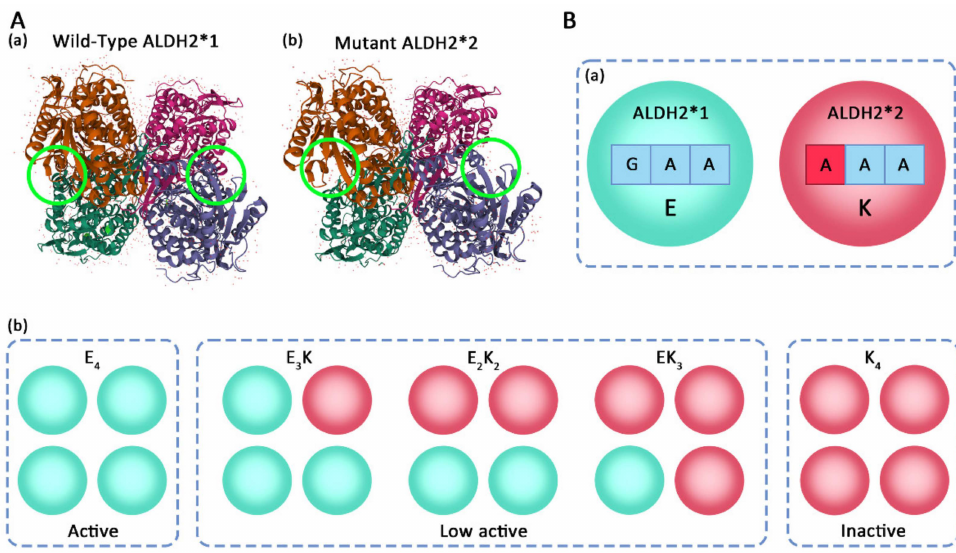
Figure 2. Tetramer structure of ALDH2. ( A ) ( a ) Tetramer structure of wild-type (WT) ALDH2 ( ALDH2*1 , Protein Data Bank [PDB] Accession Code: 1O05). ( A ) ( b ) Tetramer structure of the inactive mutant of ALDH2 ( ALDH2*2 , PDB Accession Code: 1ZUM). Green circle: the α -helix structure missing from the mutant tetramer versus WT; modified from [105]. ( B ) ( a ) “E” = subunit encoded by the WT allele ALDH2*1 ; the first base of codon 487 is guanine (G), and the 487th amino acid residue is glutamic acid (Glu/E). “K” = subunit encoded by the mutant allele ALDH2*2 ; the first base of codon 487 is mutated to adenine (A), and the 487th amino acid residue is changed from Glu to lysine (Lys/K). ( B ) ( b ) E 4 homotetramers reflect normal enzyme activity; heterologous tetramer E 3 K, E 2 K 2 , and EK 3 enzyme activities are substantially reduced; and K 4 homotetramer enzyme activities are almost